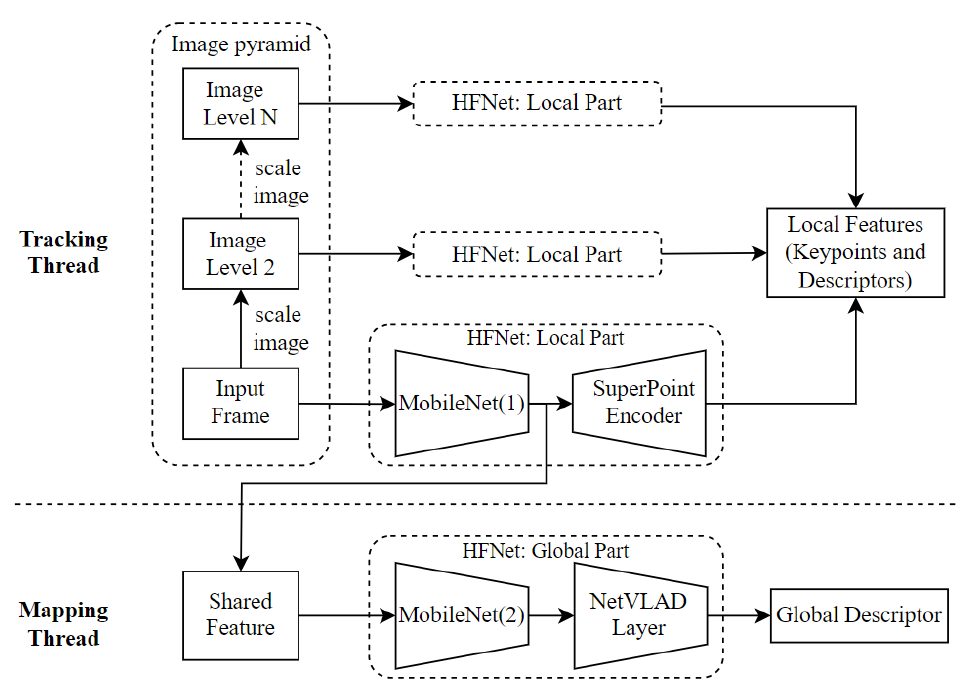
Figure 2. The feature extraction process of